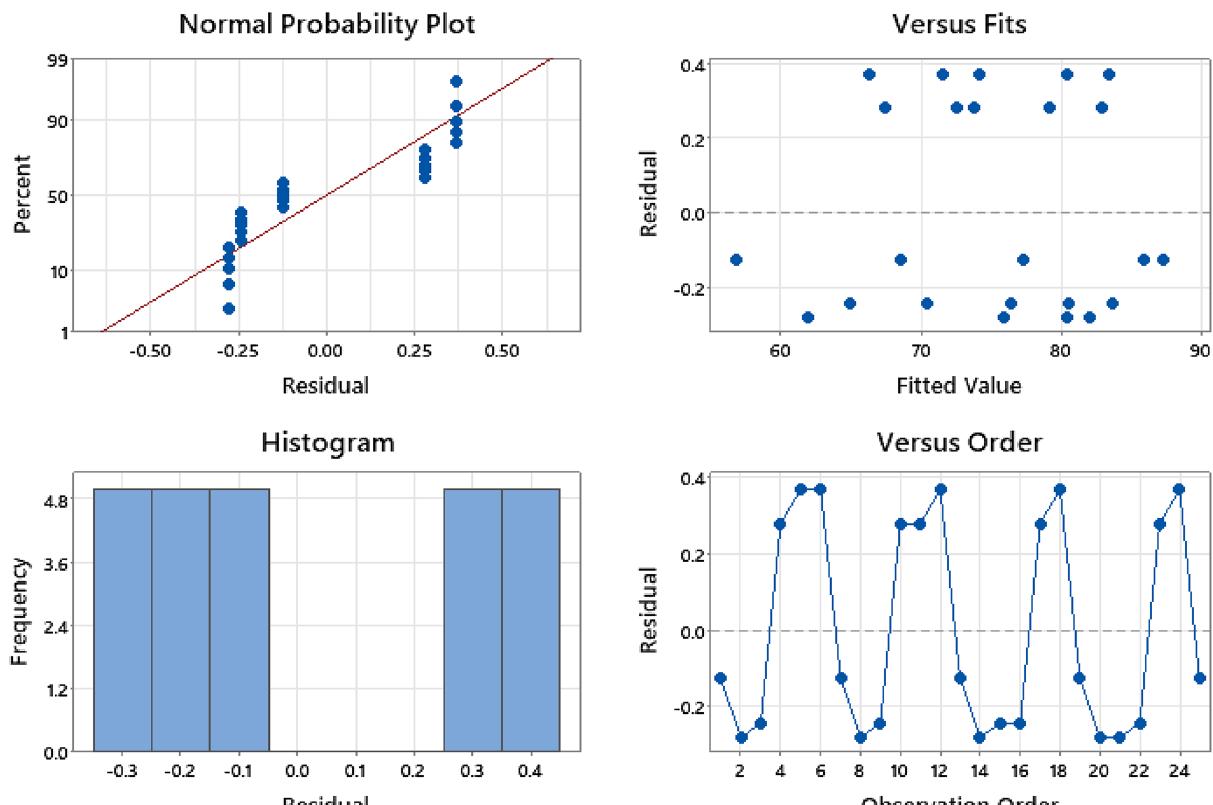
Figure 2. Residual plots of means for MB biosorption by the viable cells of P. alcaliphila